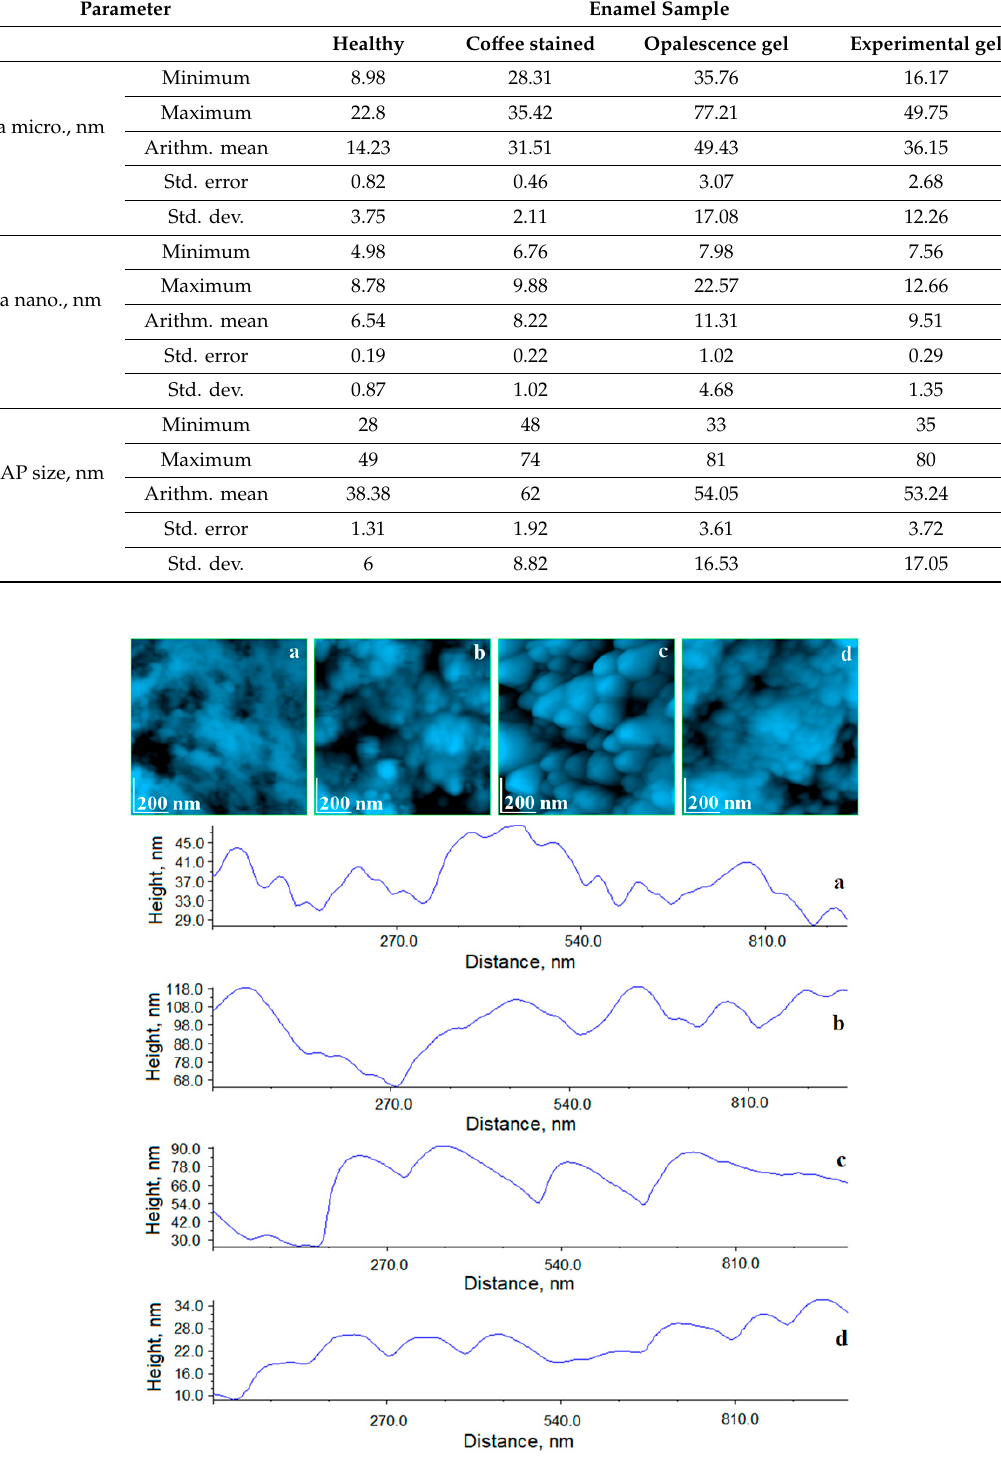
Figure 12. AFM topographic images at the nanostructure of the samples of ( a ) healthy, untreated enamel, ( b ) co ff ee stained enamel, ( c ) stained enamel and treated with Opalescence gel, and ( d ) stained enamel and treated with experimental gel. Two-dimensional profiles on the horizontal median of the topographic images are given. They are related to the roughness at the nanostructure level, “Ra nano”, in Table